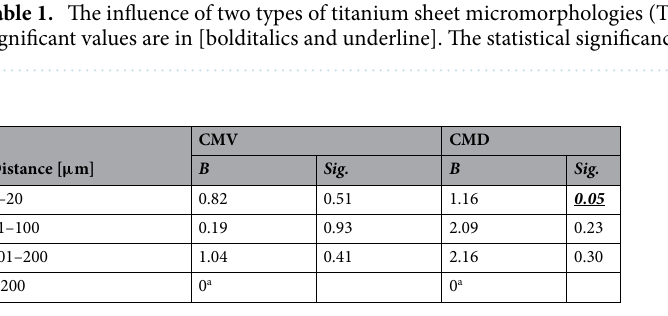
Cell movement direction (CMD) Horizontal versus away Toward versus away Groups OR Sig. OR Sig. OR Sig.